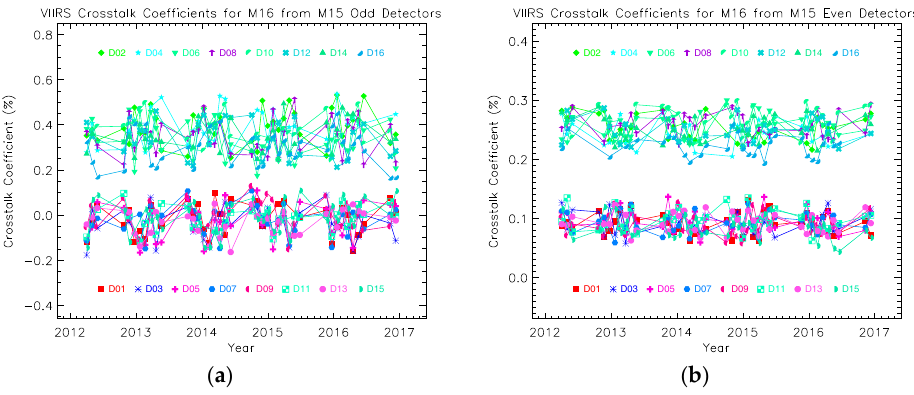
Figure 10. SNPP VIIRS Band M16 crosstalk coefficients for sending Band M15: ( a ) odd detectors and ( b ) even detectors.